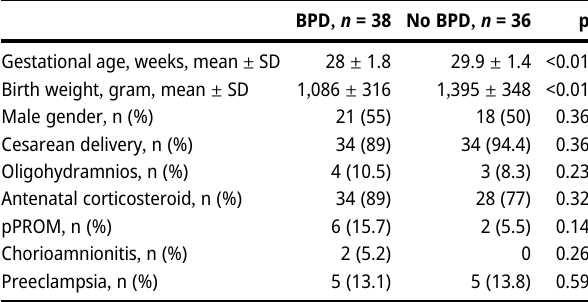
Table  : Demographic characteristics ’ of the